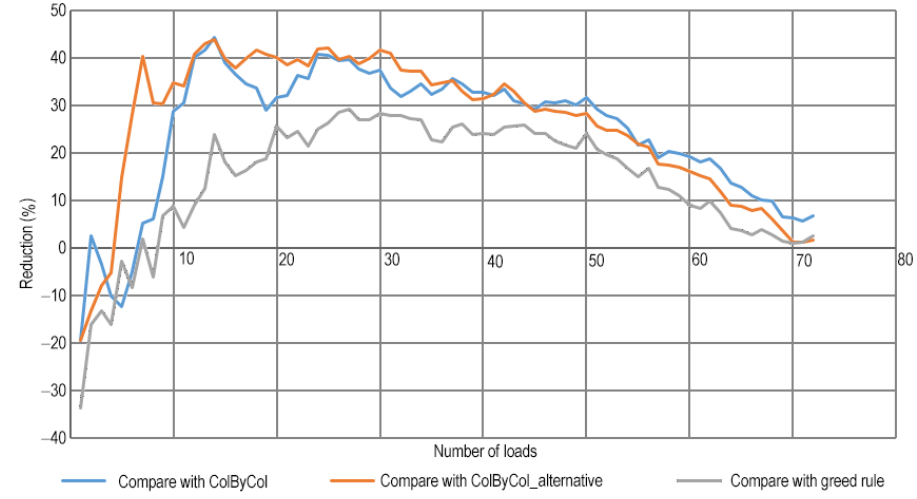
Fig. 11 Makespan of AC algorithm compared with other rules under six tiers and six columns